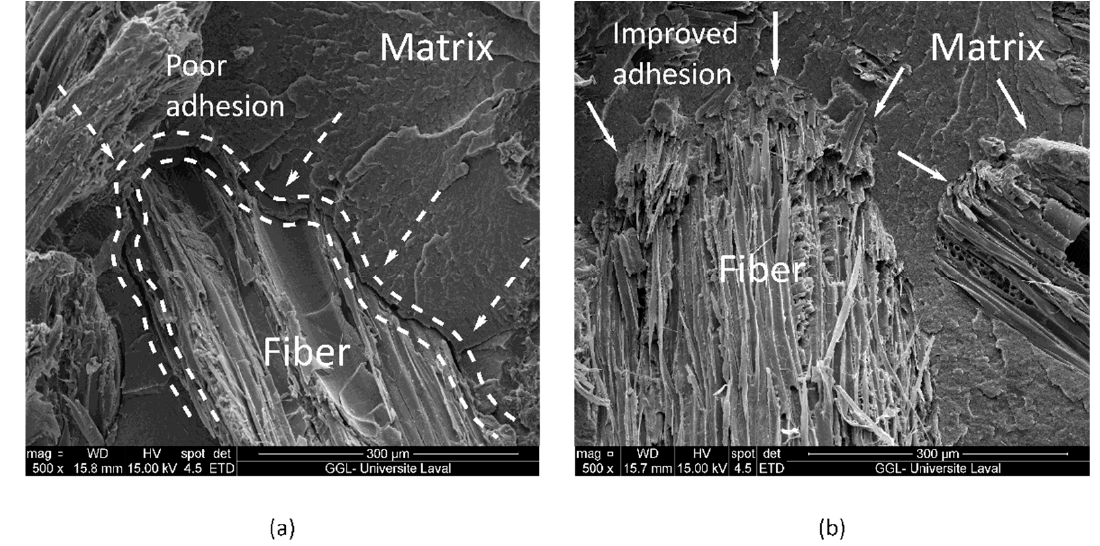
Figure 6. Interfacial state difference between recycled high density polyethylene and maple fiber composites (30 wt%) for ( a ) untreated and ( b ) treated fibers.